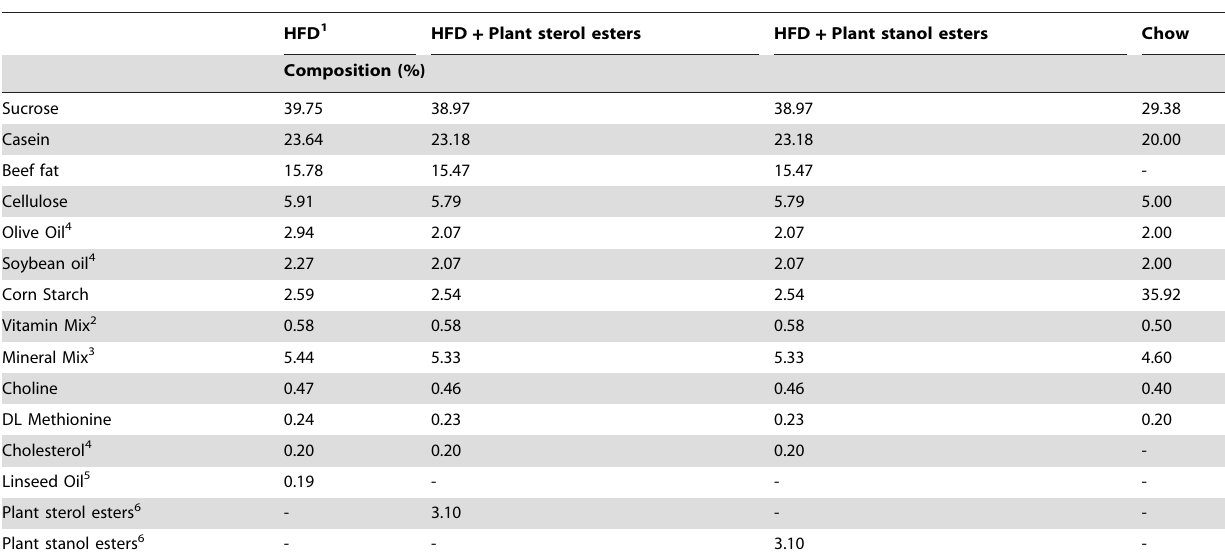
Table 3. Composition of the experimental and chow